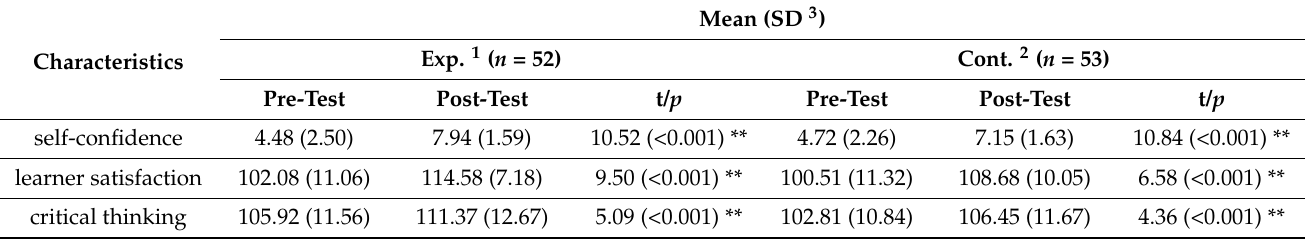
Table 4. Comparison of pretest and posttest self-confidence, learner satisfaction, and critical thinking.